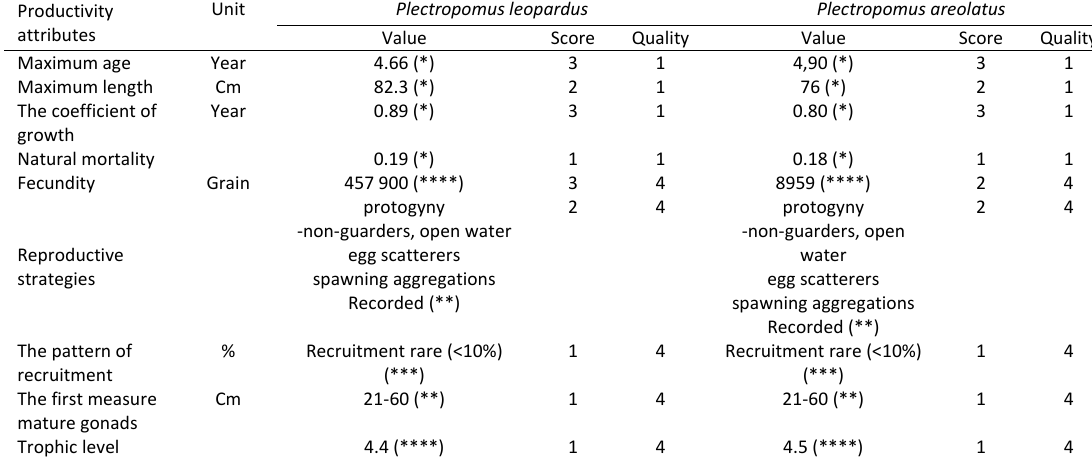
Table 3: Productivity attributes of Red and Black Groupers at Wakatobi National Park